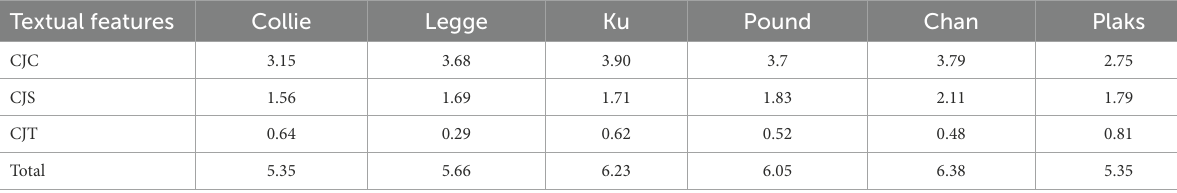
TABLE 9 Statistics of conjunction usage of the six TTs (in percentage). Textual